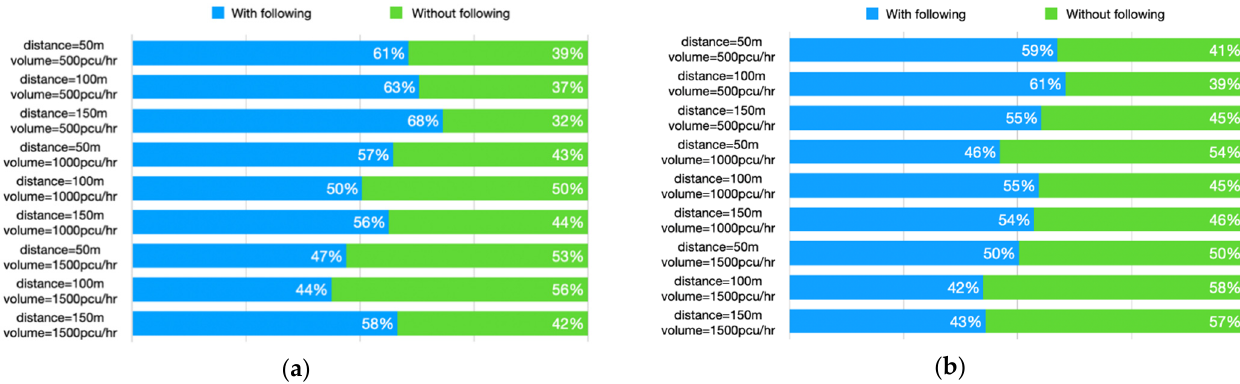
Figure 5. ( a ) Mean lateral Acc/Dec profiles when IDCTS = 50 m and volume = 500 pcu/h; ( b ) mean lateral Acc/Dec profiles when IDCTS = 100 m and volume = 1000 pcu/h; ( c ) mean lateral Acc/Dec profiles when IDCTS = 150 m and volume = 1500 pcu/h.